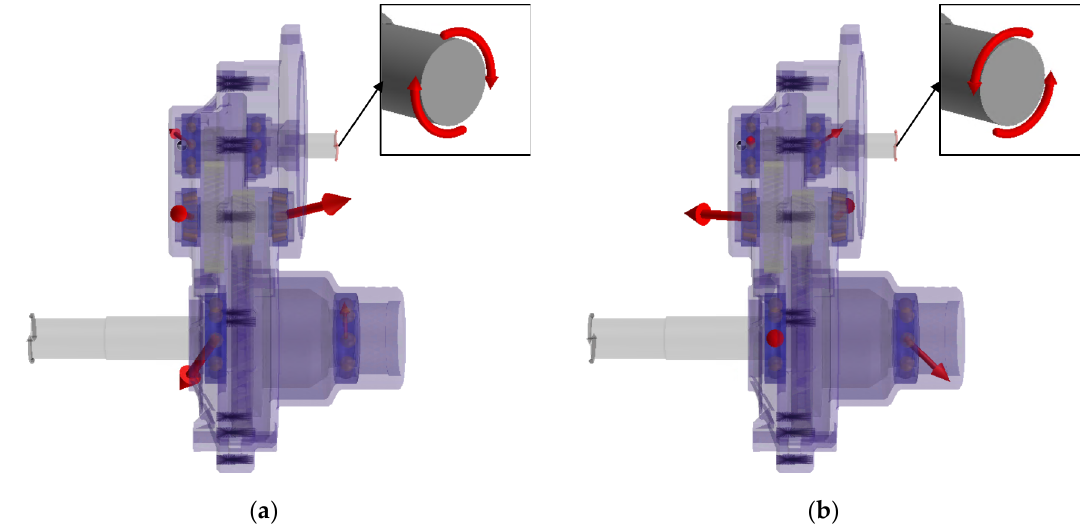
Figure 9. Bearing reaction force according to the rotational direction of the input shaft. ( a ): Clockwise rotation of the input shaft; ( b ): Counterclockwise rotation of the input shaft.